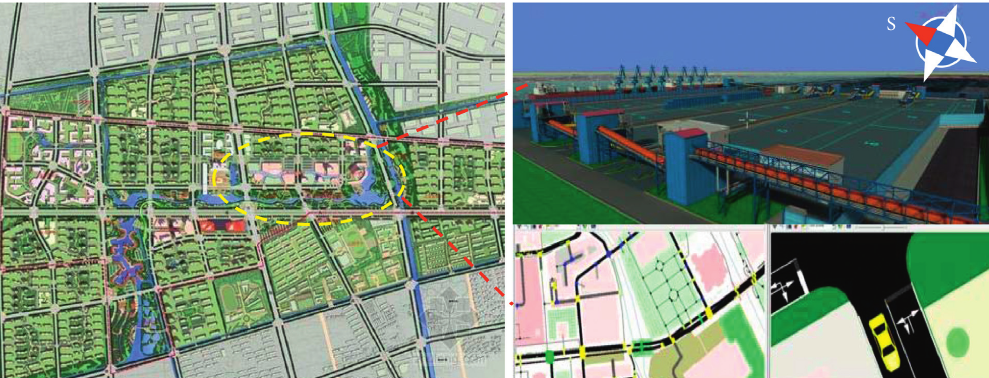
Figure 3: Road map and simulation design